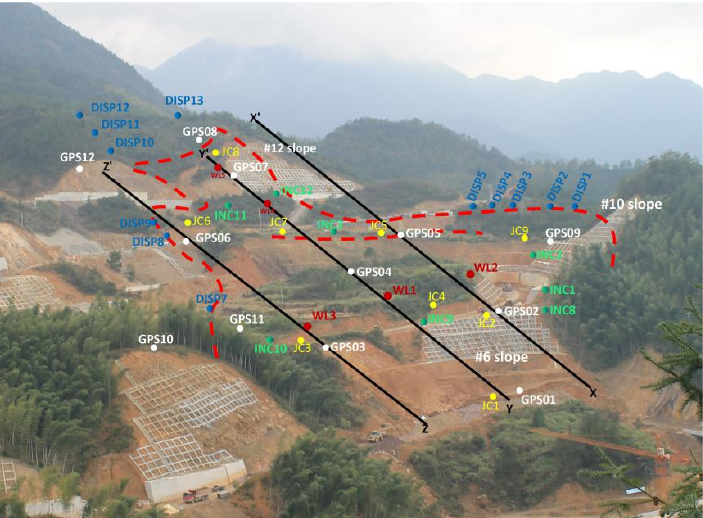
Figure 6. Deployment of the monitoring system in the project site, in which the red dashed dots indicate the landslide outline. White circles indicate the GPS benchmarks, yellow circles indicate the deep inclinometers, green circles indicate the tilt meters, dark blue circles indicate the crack meters and dark red circles indicate the groundwater level indicators.